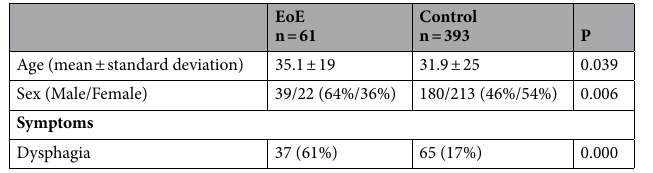
Table 1. Baseline characteristics of patients whose images were included in the study.